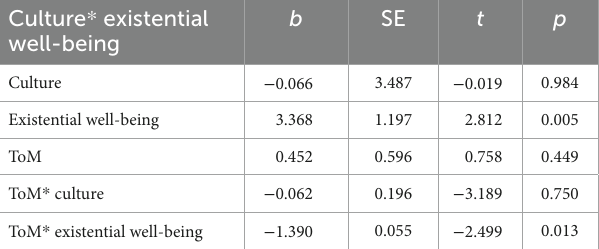
TABLE 8 Moderating role of culture and existential well-being on the relationship between ToM and prosocial behaviour. Culture * existential b SE t well-being